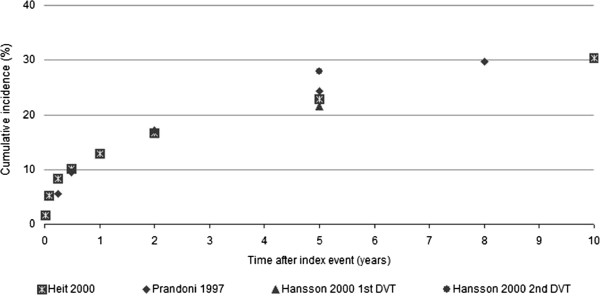
Rates of VTE recurrence in registry patients[3-5].